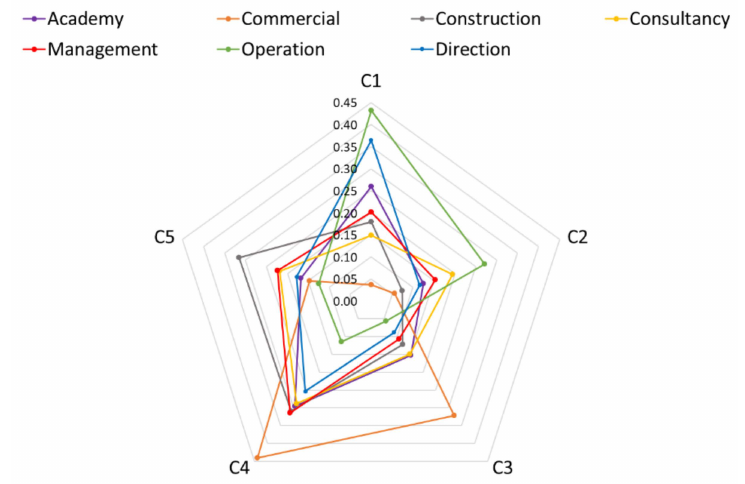
Figure 5. Importance weight of criteria of every group of